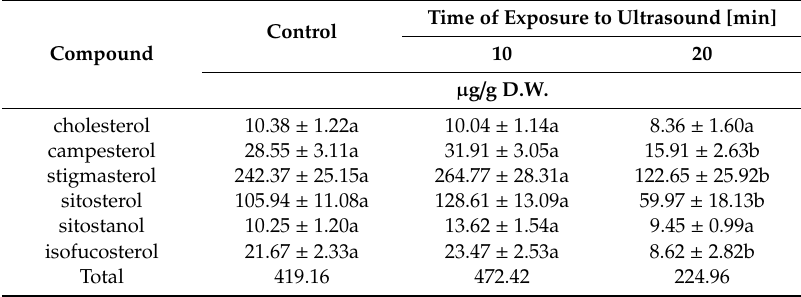
Table 6. The content of sterols in line CH2 hairy root tissue after elicitation with ultrasound.